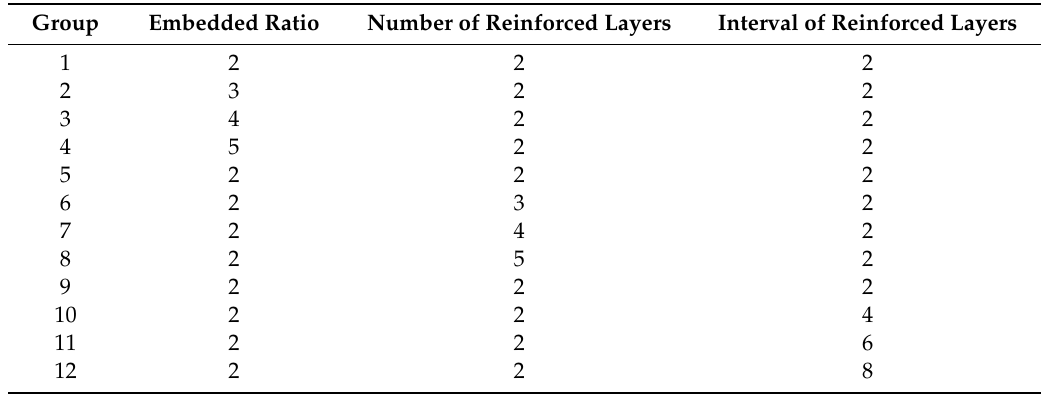
Table 5. The plan of experiment